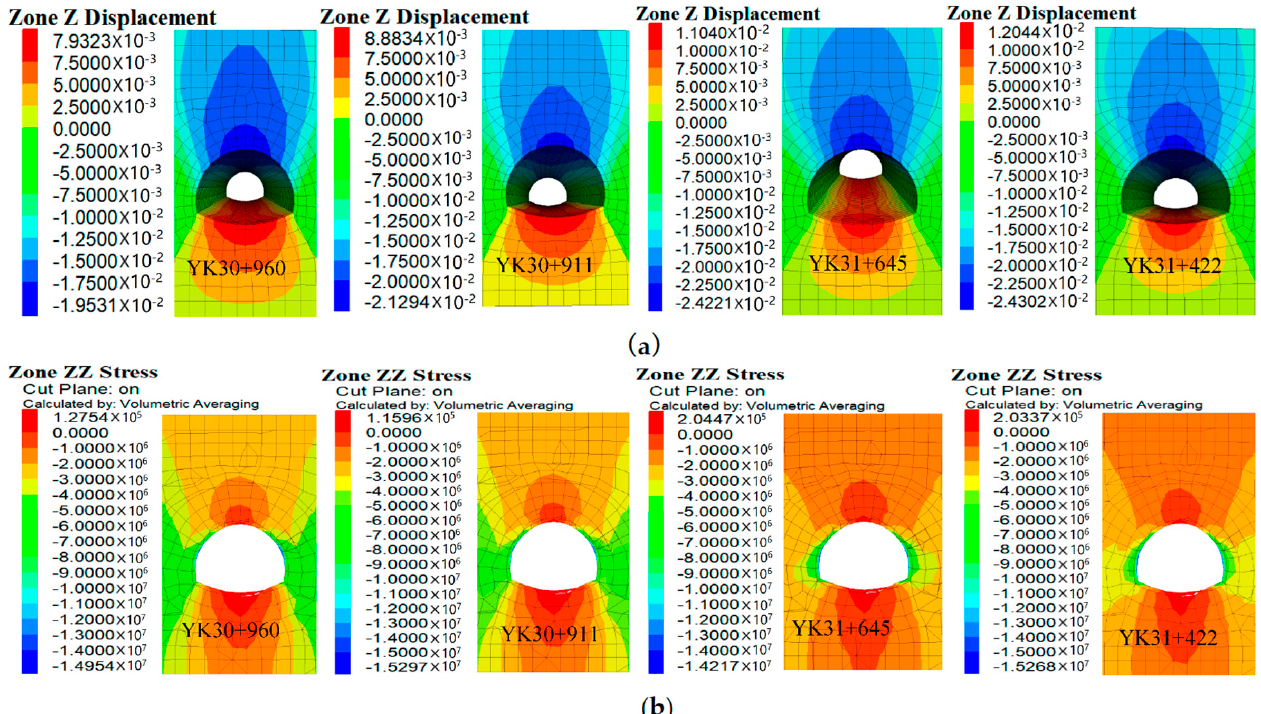
Figure 9. Nephogram of displacement and stress changes of different monitoring sections: ( a ) dis- placement nephogram; ( b ) stress nephogram.